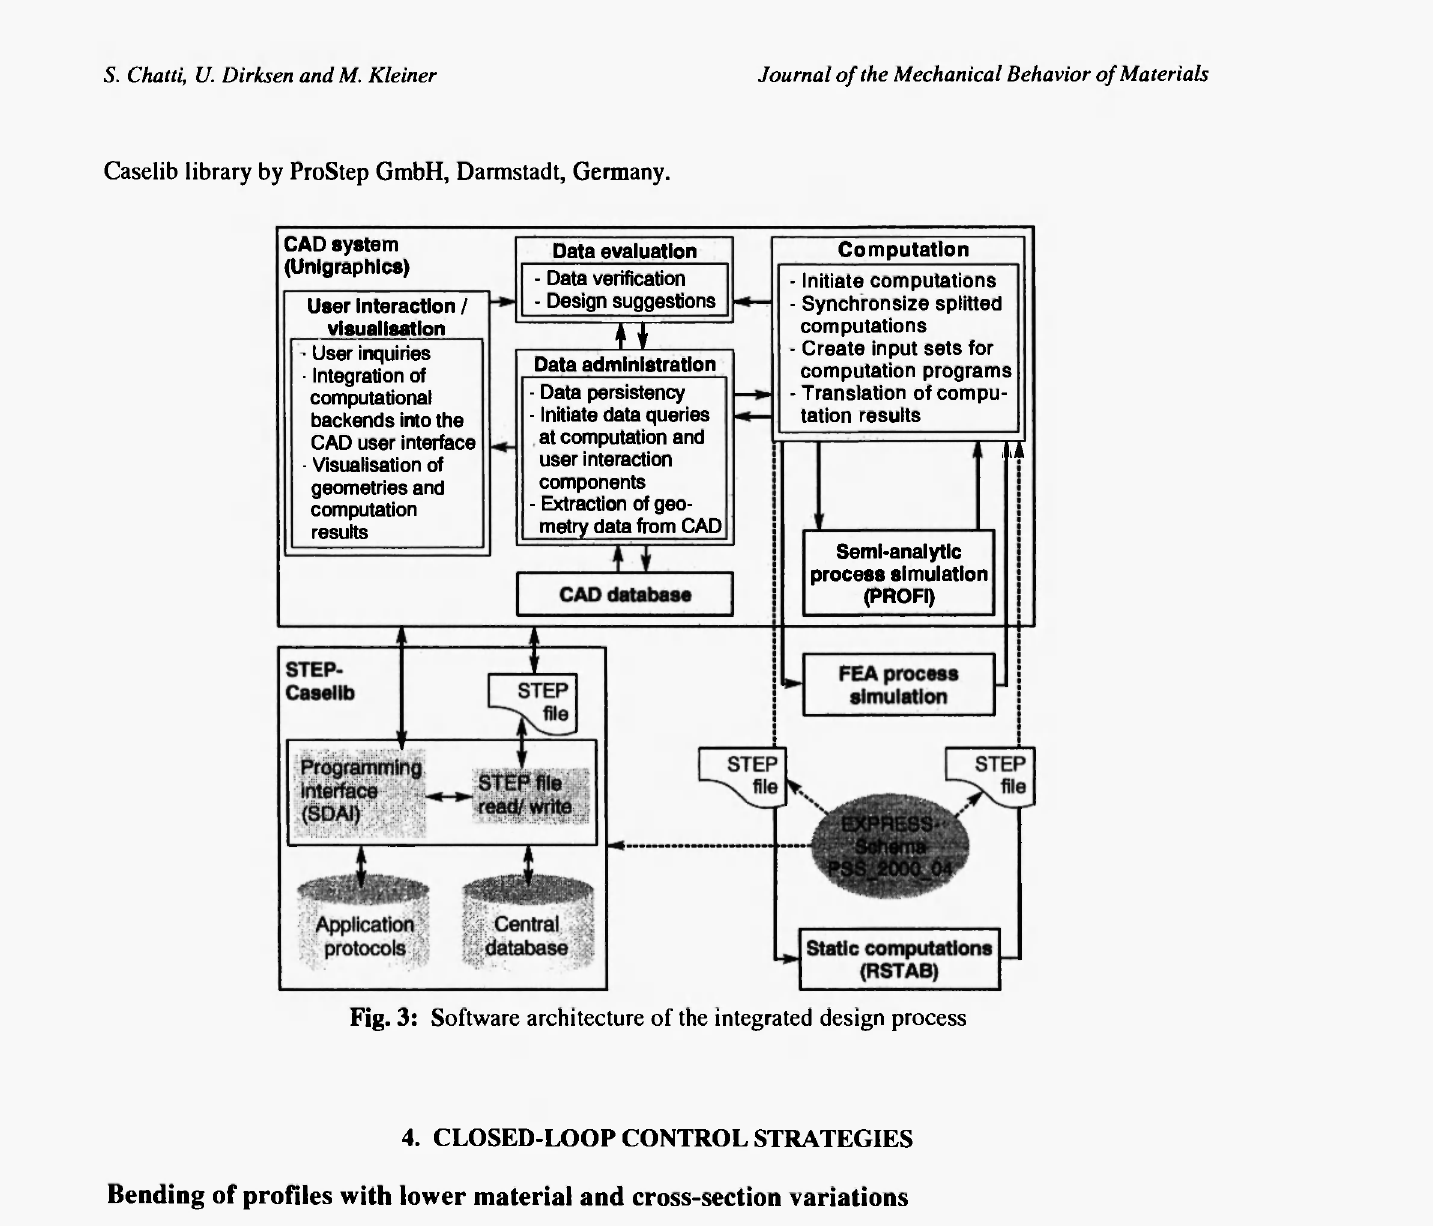
Fig. 3: Software architecture of the integrated design